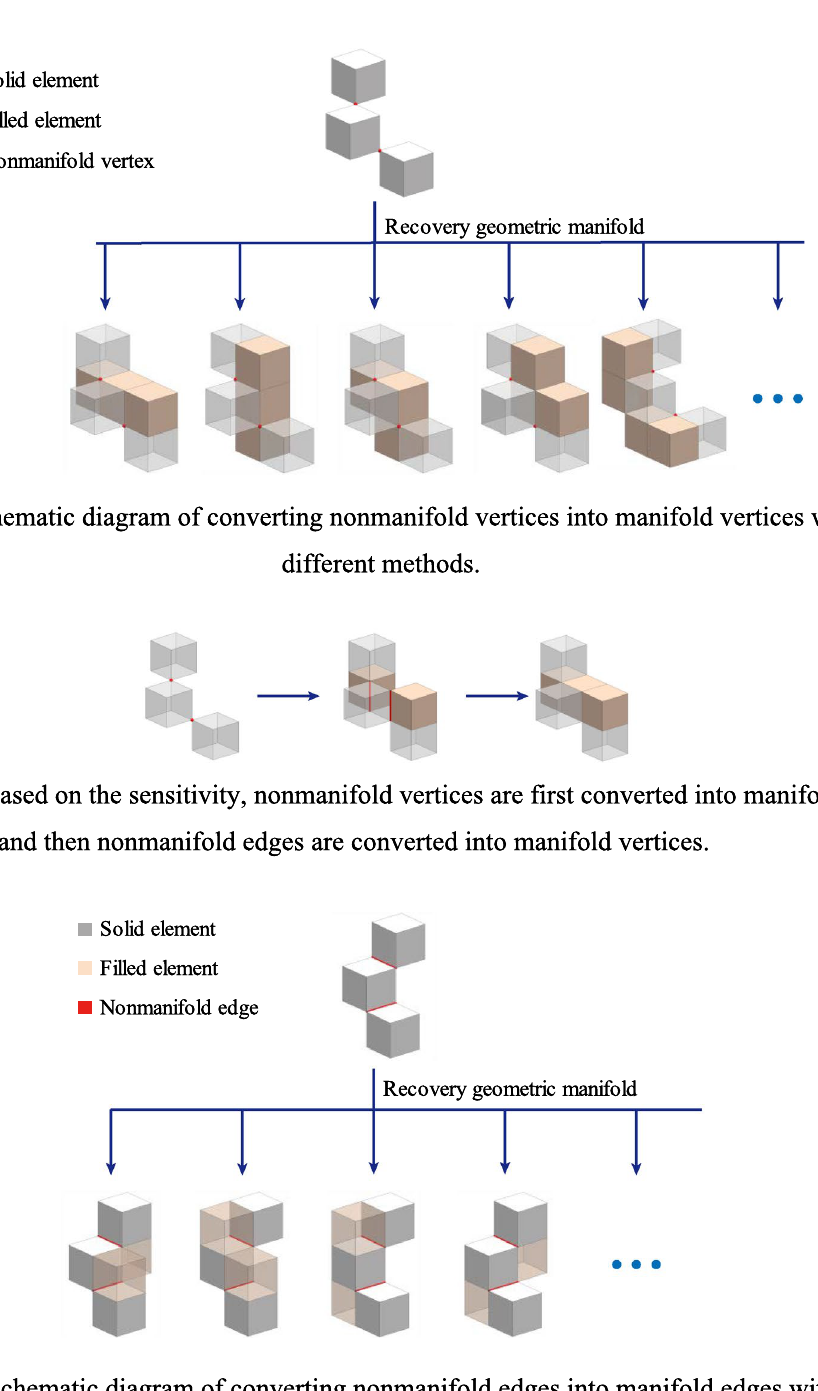
Figure 3. The strategy of recovering geometric manifold for nonmanifold